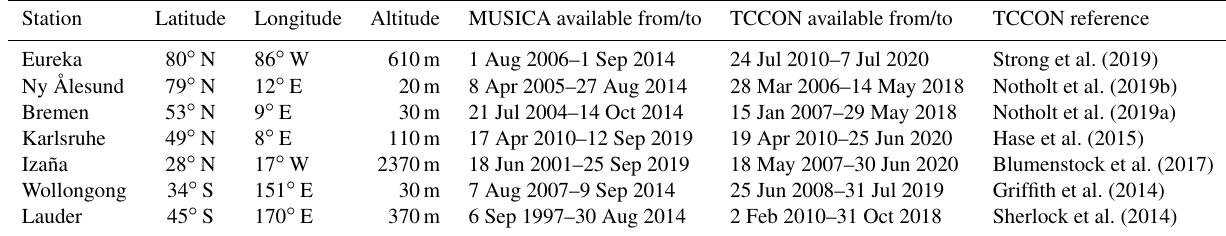
Table 3. List of ground stations used for the derivation of the FTIR correction. Station Latitude Longitude Altitude MUSICA available from/to TCCON available from/to TCCON reference Eureka 80 ◦ N 86 ◦ W